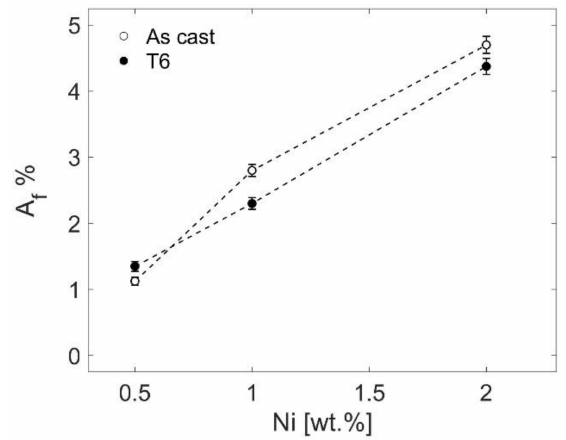
Figure 8. The A f % of Ni-based compounds in as-cast and T6 heat-treated alloys as a function of Ni